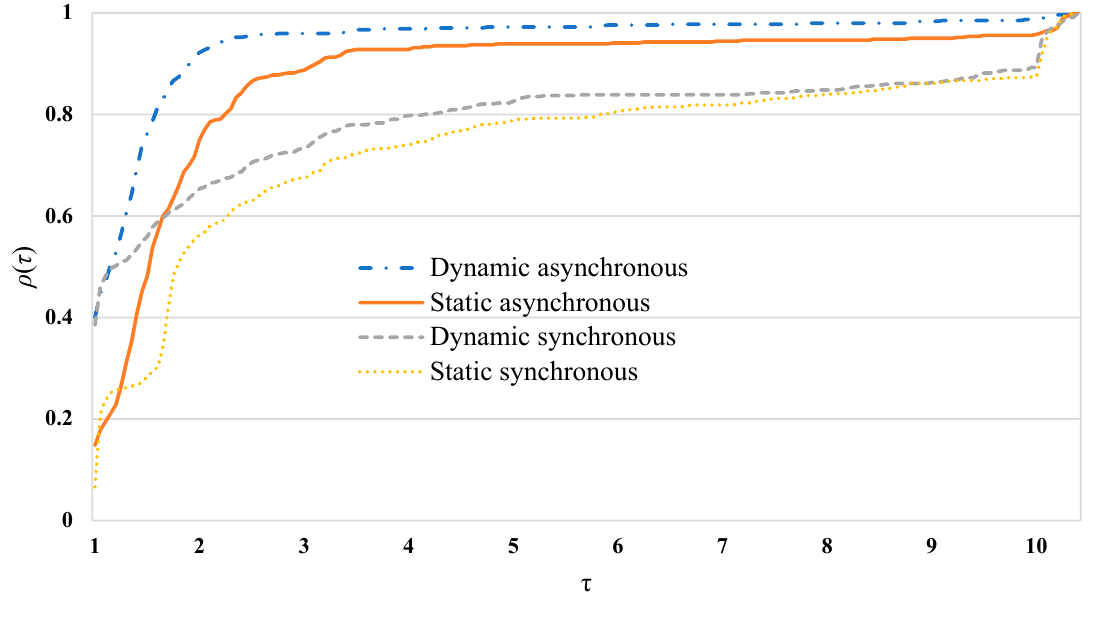
Figure 1. Performance profiles over the set E .